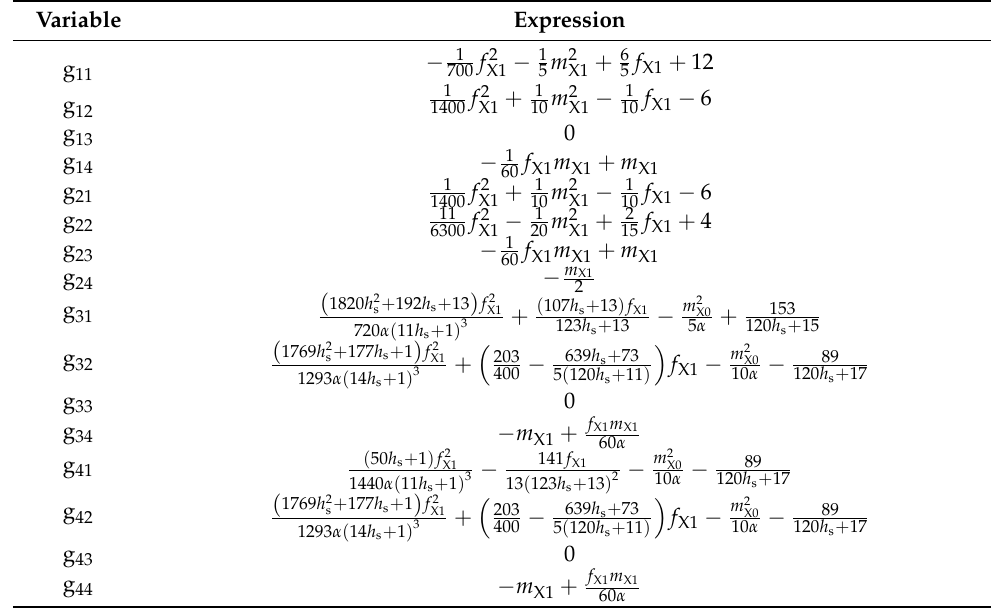
Table 1. Expressions of the variables in Equation